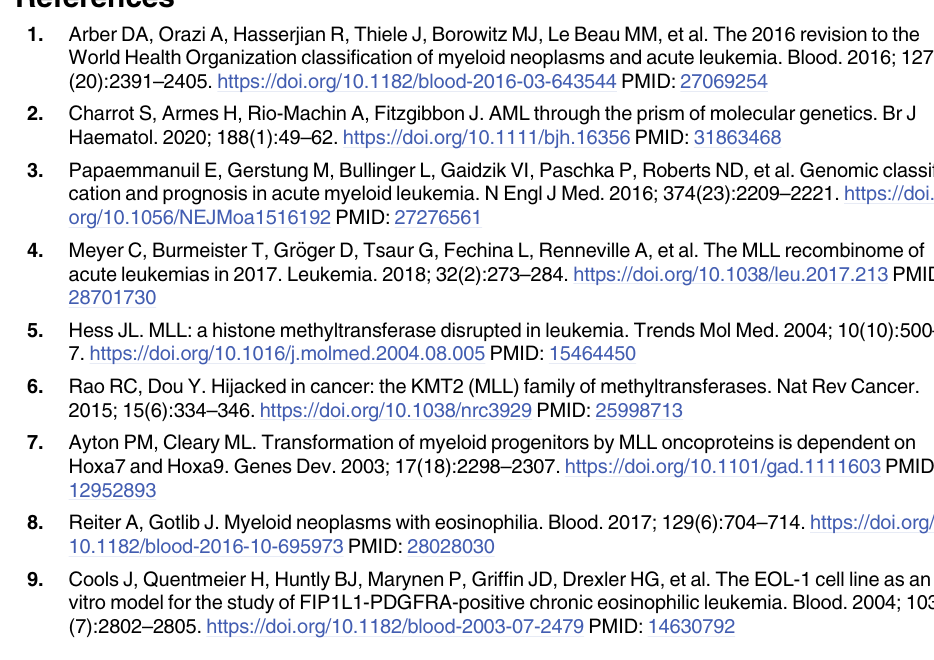
S1 Table. Comparative expression profiling data of selected AML cell lines. Group 1 (EOL- 1 and MV4-11) has been compared to group 2 (GDM-1, HL-60 and KG1). Expressed genes are listed according their log-fold expression level. Additionally indicated are average expres- sion levels and adjusted p-values. Upregulated and downregulated genes in group 1 are labeled in orange and green,